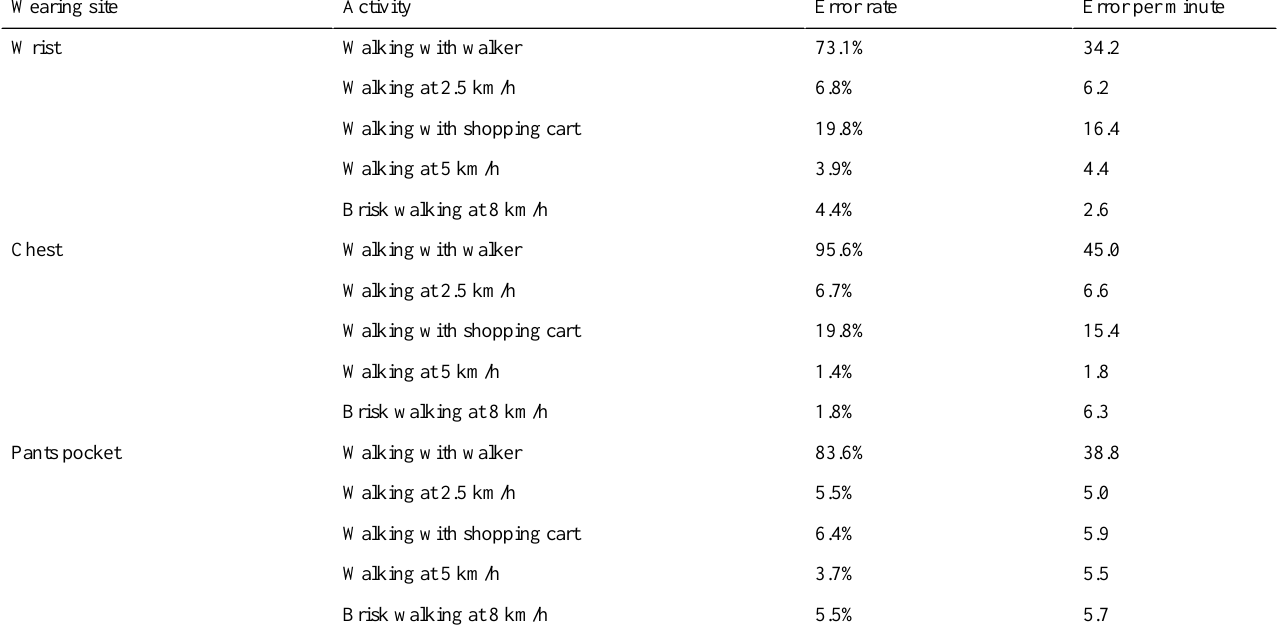
Table 3. Error rate and error per minute values for trackers.